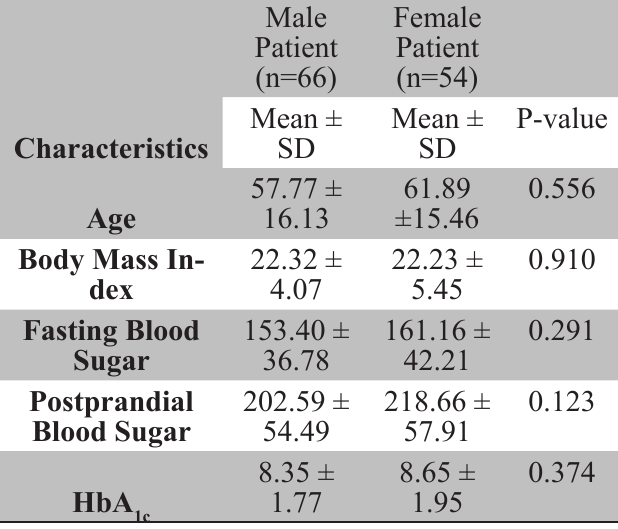
Table 1. Demographic and clinical data in different genders.